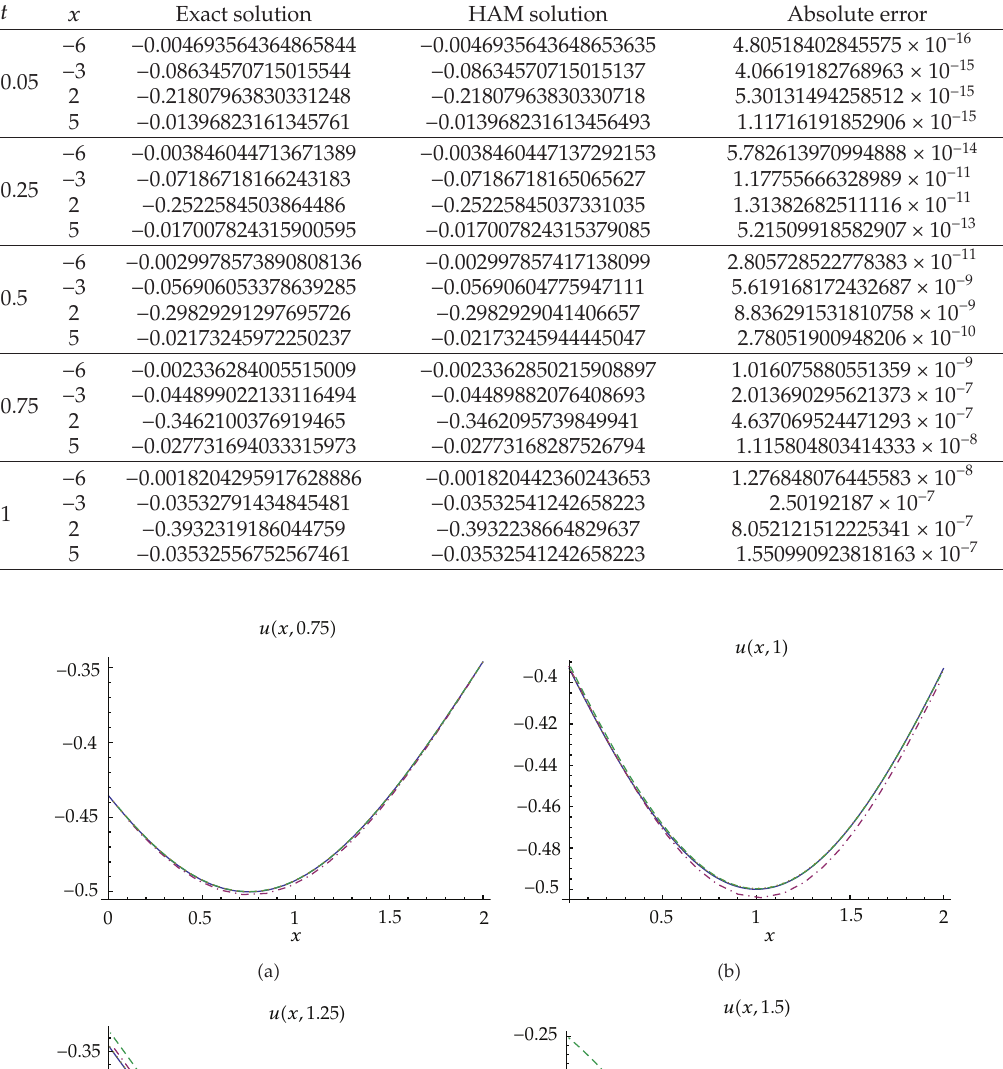
Table 1: Comparison of the HAM solution with exact solution when ħ (cid:8) − 1 and t (cid:8) 0 , 0 . 25 , 0 . 5 , 0 . 75 , 1, respectively.